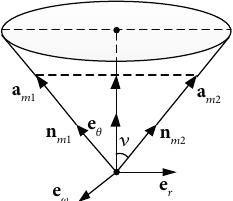
Figure 4: Guidance command conversion.